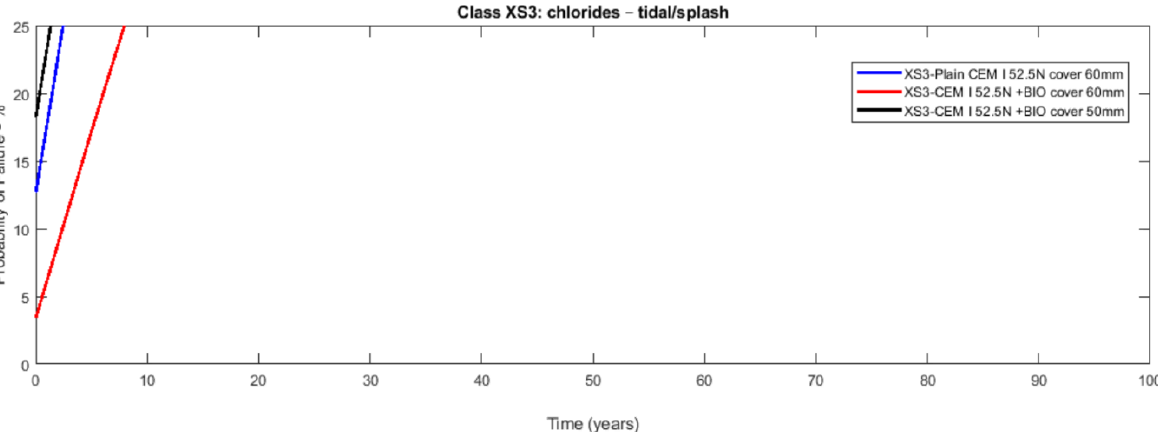
Figure 7. Probabilistic service life results of CEM II/A-D concrete — exposure class XS2 (submerged) — without and with AACI for a cover of 60 and 50 mm.